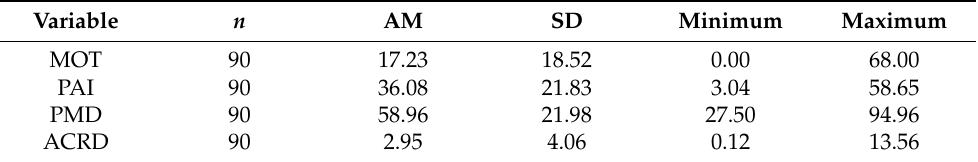
Table 1. Summary statistics of database structure for spermatozoa cells diluted in three commercial extenders supplemented with different extenders and 9% NMA after thawing.